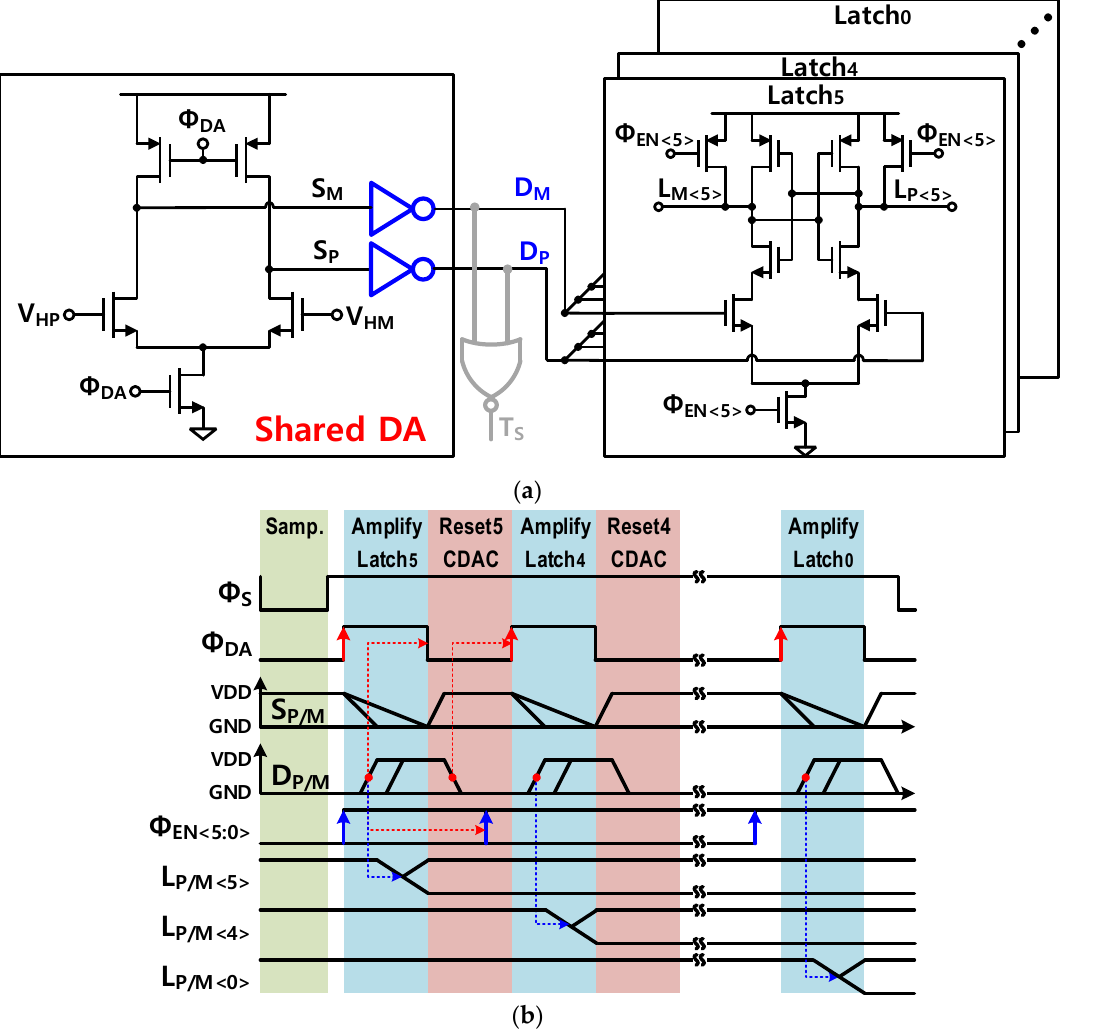
Figure 4. Inverter ‐ inserted three ‐ stage comparator. ( a ) Circuit and ( b ) timing